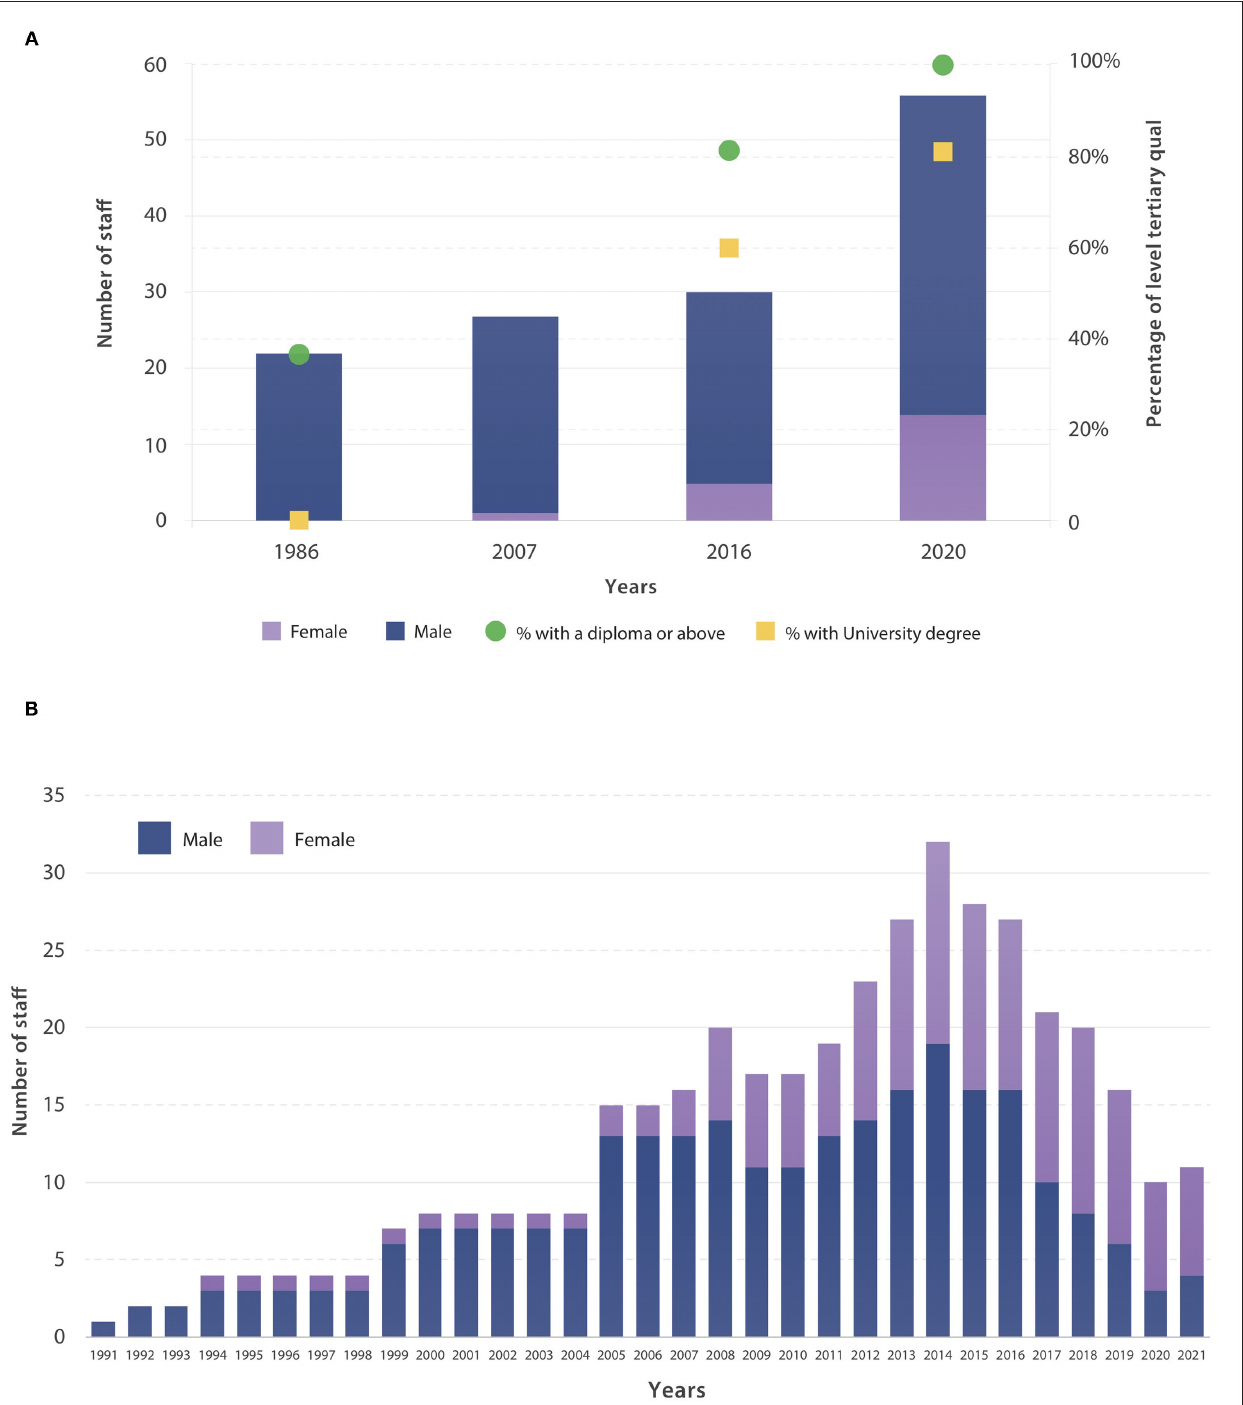
FIGURE 1 | (A) MFMR national staff in technical divisions focused on coastal fisheries management and community development. All years represent filled positions to the extent it could be ascertained from available data. 2007 is an overestimate of filled positions as it was not possible to disaggregate the data into filled and vacant posts, nor were data on staff qualifications available. (Sources: Govan et al., 2013; MFMR and MSSIF Human Resources Sections; Mike Batty, pers. comm.). (B) WorldFish staff in Solomon Islands. These staff do not include overseas-posted staff who travel to Solomon Islands in programs and projects. (Source: WorldFish Human Resources